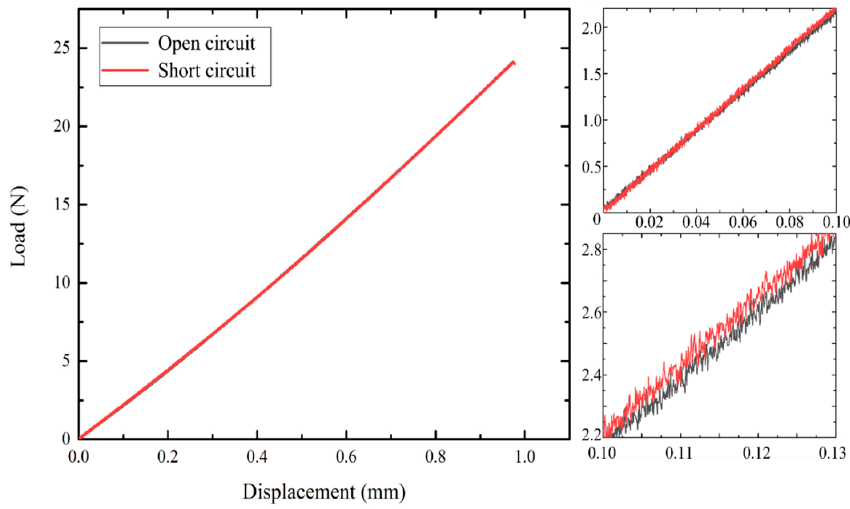
Figure 9. Load–displacement curve of the open circuit and short circuit situations.